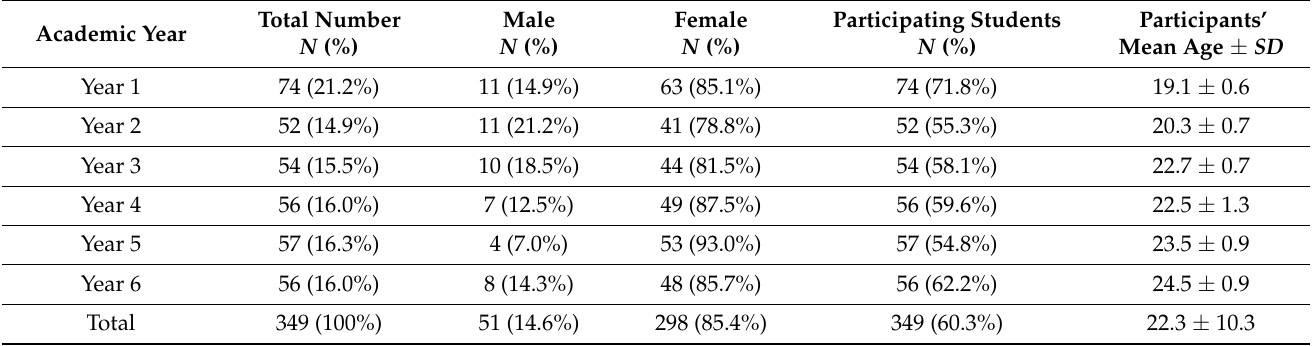
Table 1. Response rate and distribution of students by academic year, gender, and